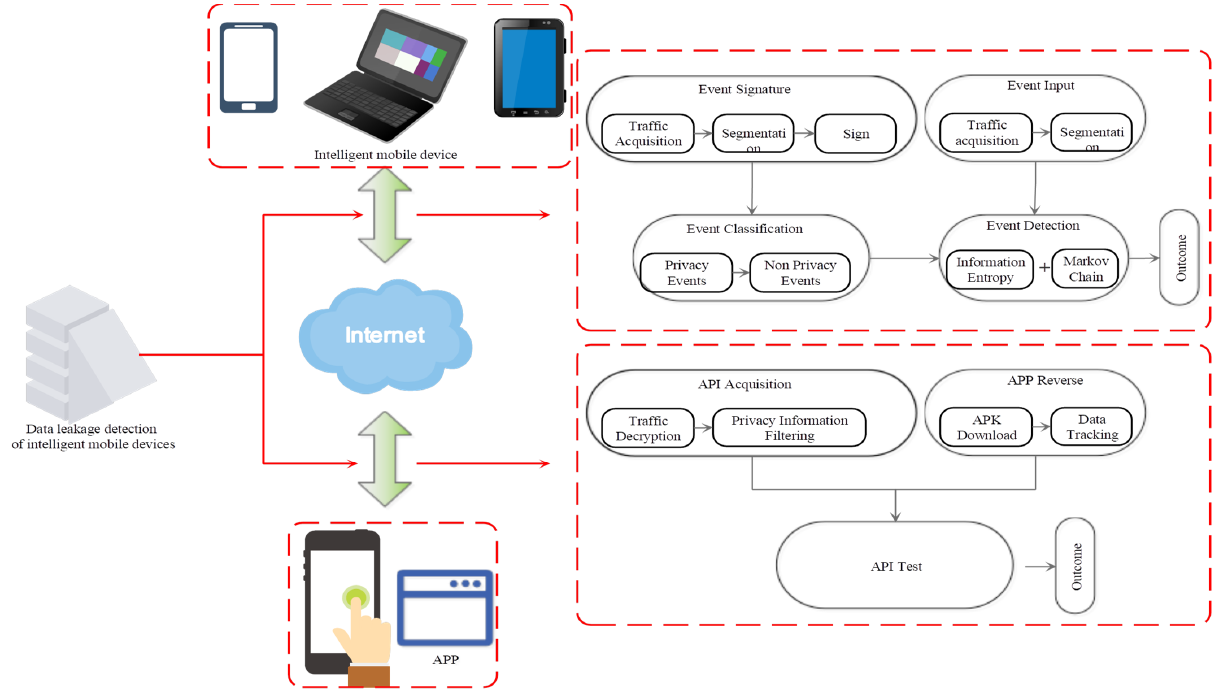
Figure 3. The data leakage detection process of intelligent mobile devices.